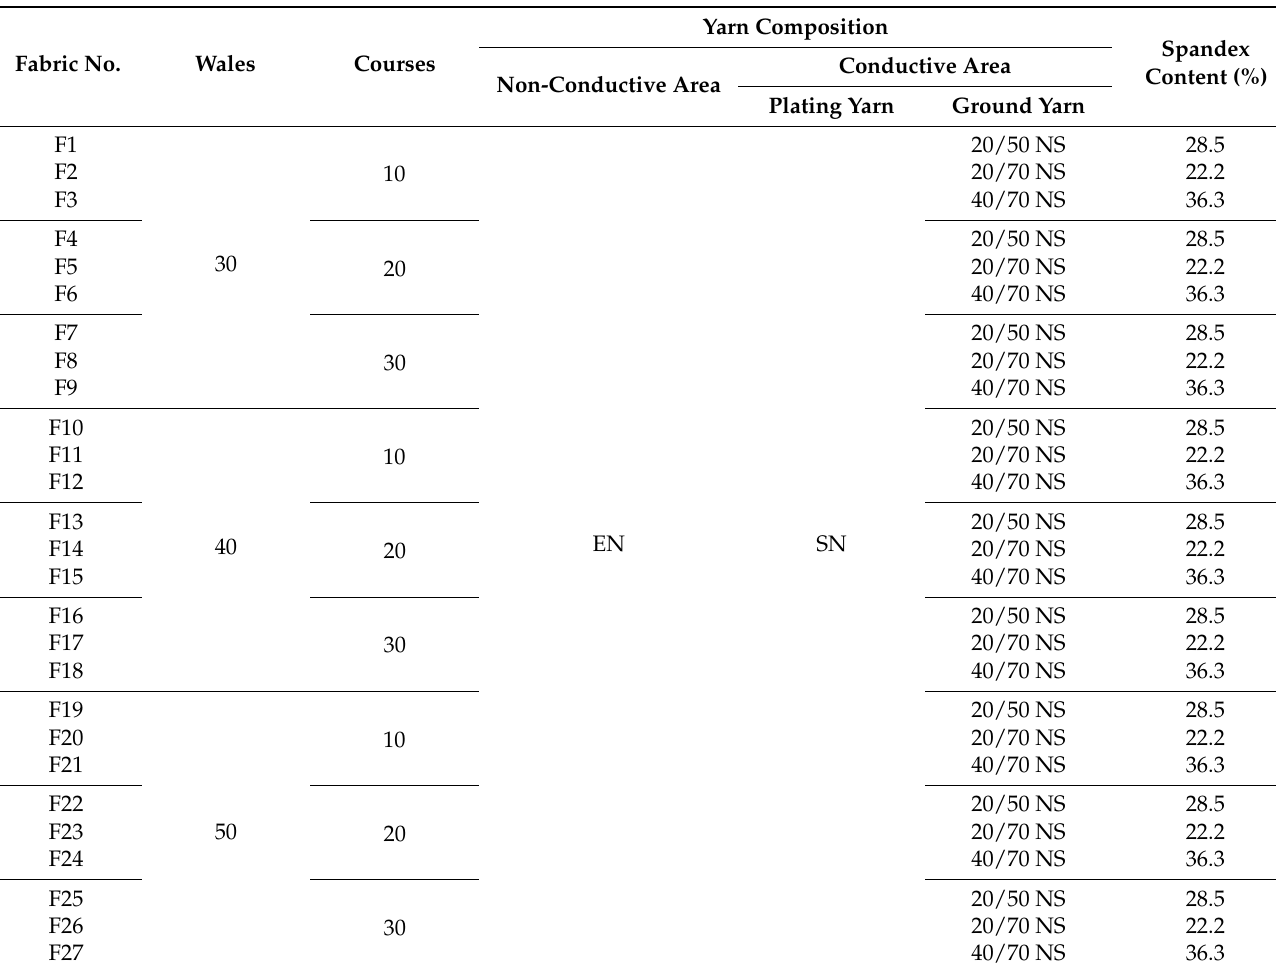
Table 1. Knitting parameters of the experimental